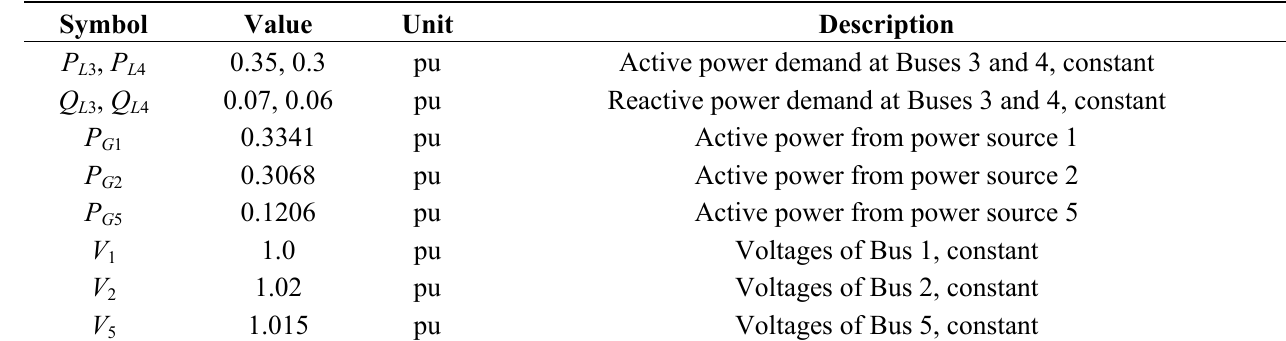
Table 2. Initial conditions for